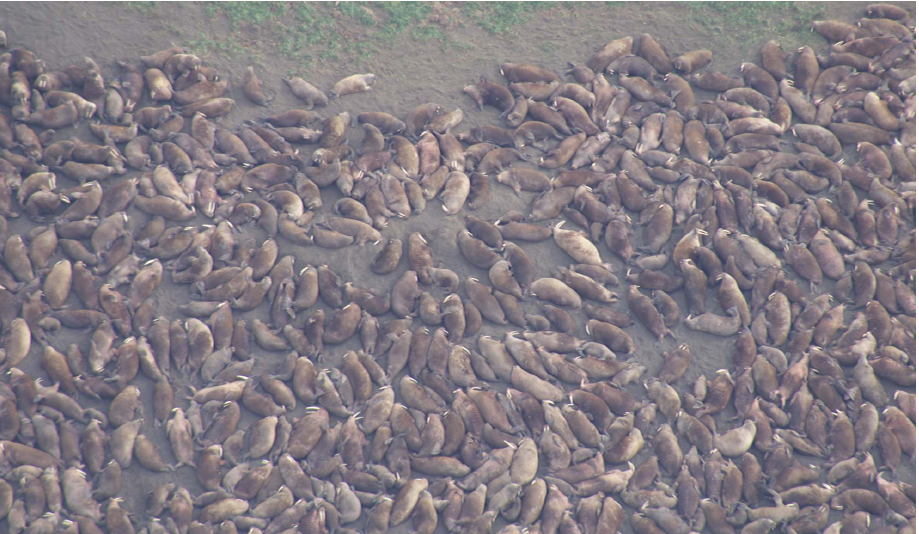
Figure 3. Example Cineflex image taken at an altitude of approximately 1220 m. Image of Pacific walruses hauled out on the northwest coast of Alaska on 26 August 2011. Image is projected at 100% though video and reference image resolution allowed tusk:snout measurements to be made at 400% or more digital zoom. Pixel size is , 1.3 cm.